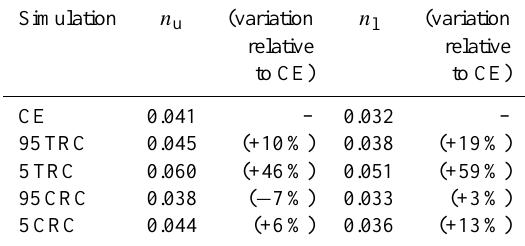
Table 1. Calibrated Manning’s roughness coefficients for upper and lower reaches, n u and n l , and different models: quasi-2-D model from Piacenza to Pontelagoscuro (Calibration Event-CE); Cremona-Pontelagoscuro model calibrated referring respectively to Traditional rating-curves (5TRC and 95TRC), and Constrained rating-curves (5CRC and